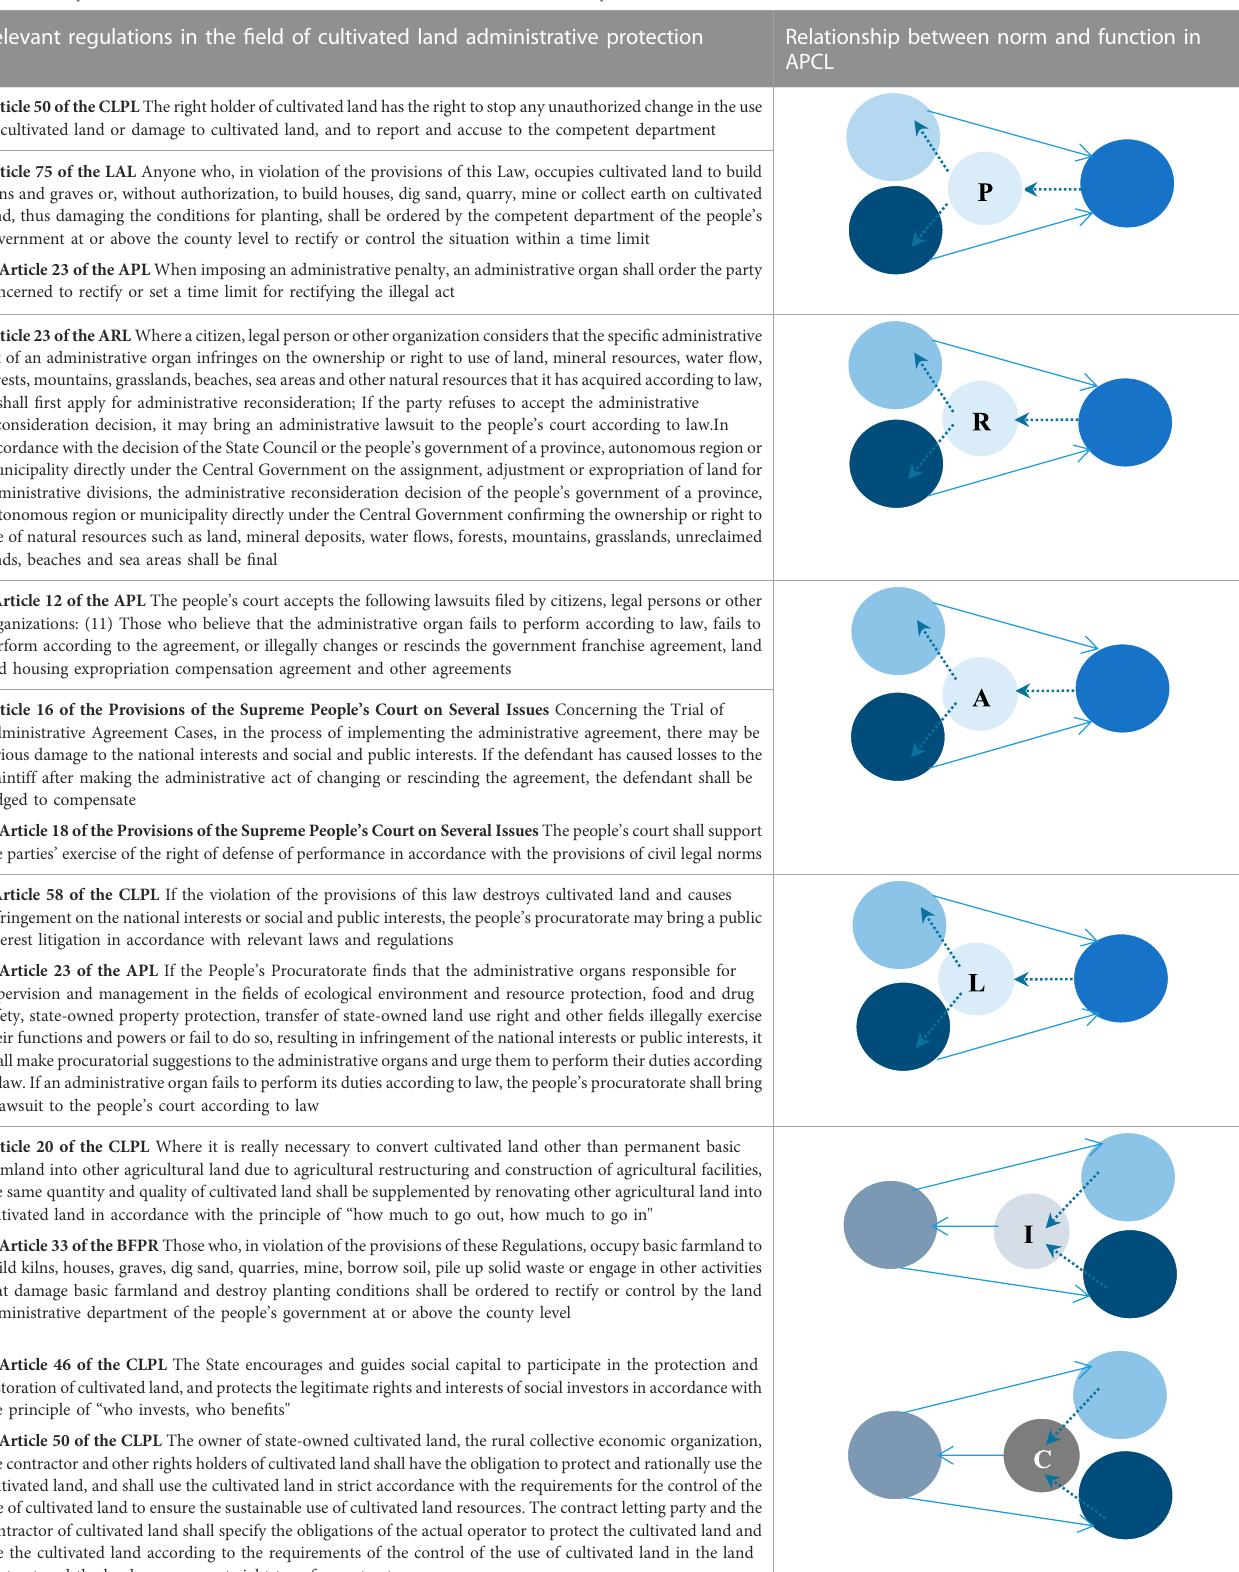
TABLE 1 Idle phenomenon of administrative reconsideration of cultivated land